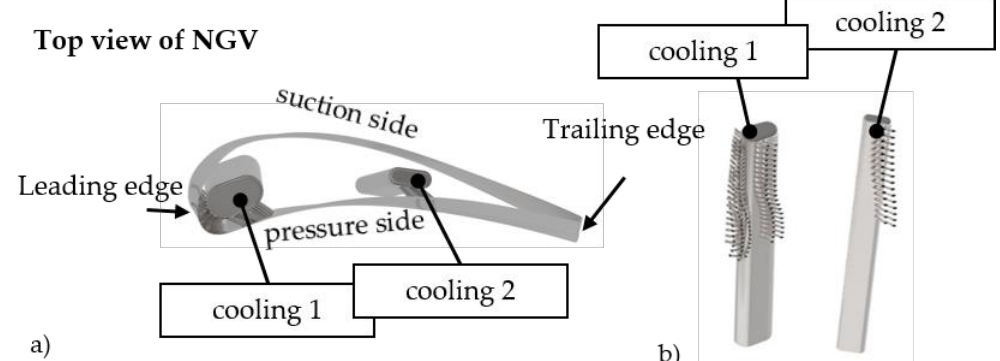
Figure 4. Nozzle guide vane with cooling holes ( a ) and details of plenum close to leading edge and pressure side ( b ).